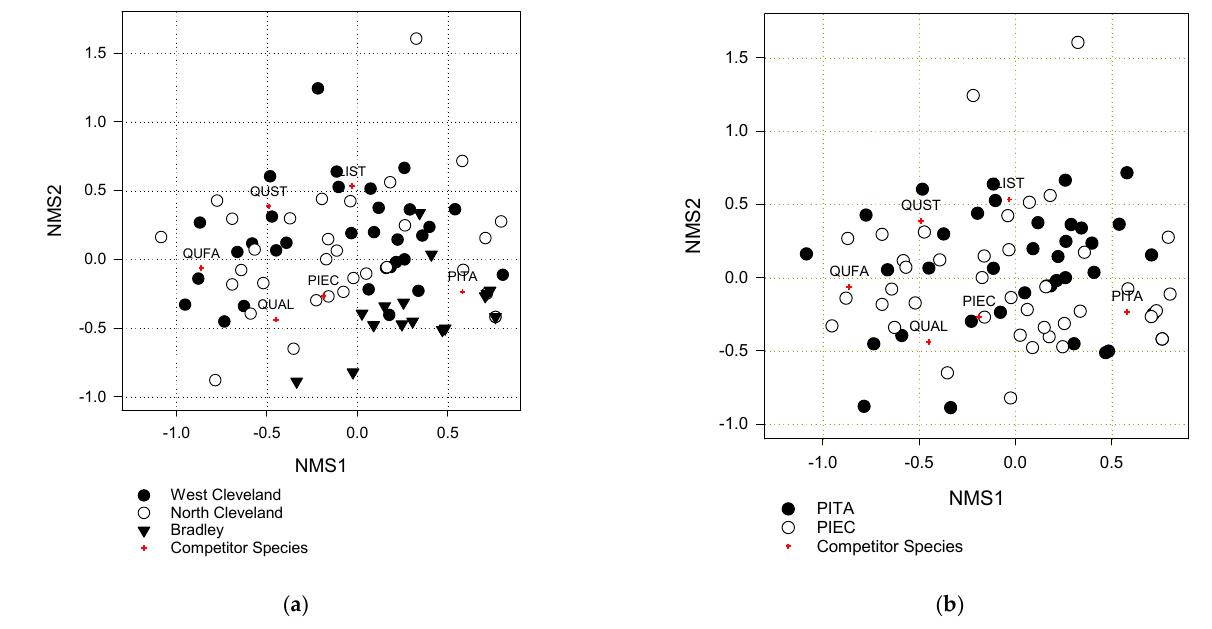
Figure 2. Ordination of focal tree neighborhoods (symbols) in competitor identity (crosshairs; PITA = Pinus taeda ; PIEC = Pinus echinata ; QUFA = Quercus falcata ; QUAL = Quercus alba ; LIST = Liquidambar styraciflua ; and QUST = Quercus stellata ) space created with the first two axes of nonmetric multidimensional scaling, with: ( a ) stand and ( b ) focal tree species membership overlay.